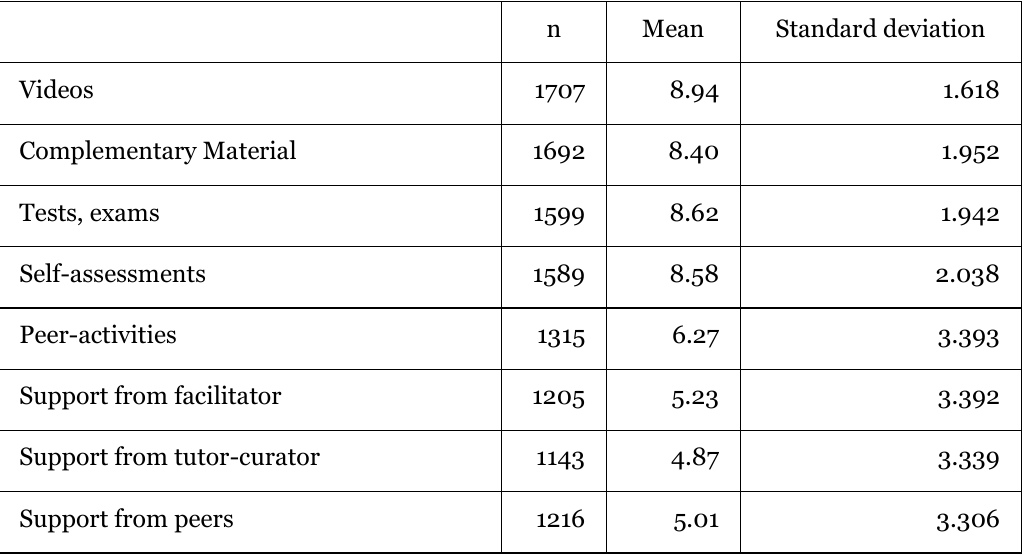
Degree of Use of MOOCs Tools (from 1 to 10)